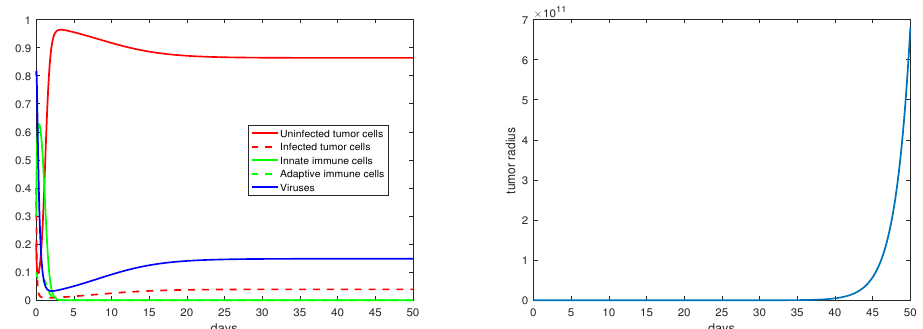
Figure 3. The equilibrium I 0 = ( 0.86,0.04,0,0,0.15 ) is asymptotically stable and the tumor radius is exponentially increasing when δ > µ and R 0 = 1.11 < min { r = 6.05, R 1 = 1.17, R 2 = 1.36 } . The values of the parameters are: λ = 2, β = 3.5, k 1 = 1, k 2 = 2, s 1 = 60, s 2 = 20, c 1 = 2, c 2 = 1, δ = 10, k 0 = 1.5, γ = 2.5, µ = 2.5, b = 0.95.